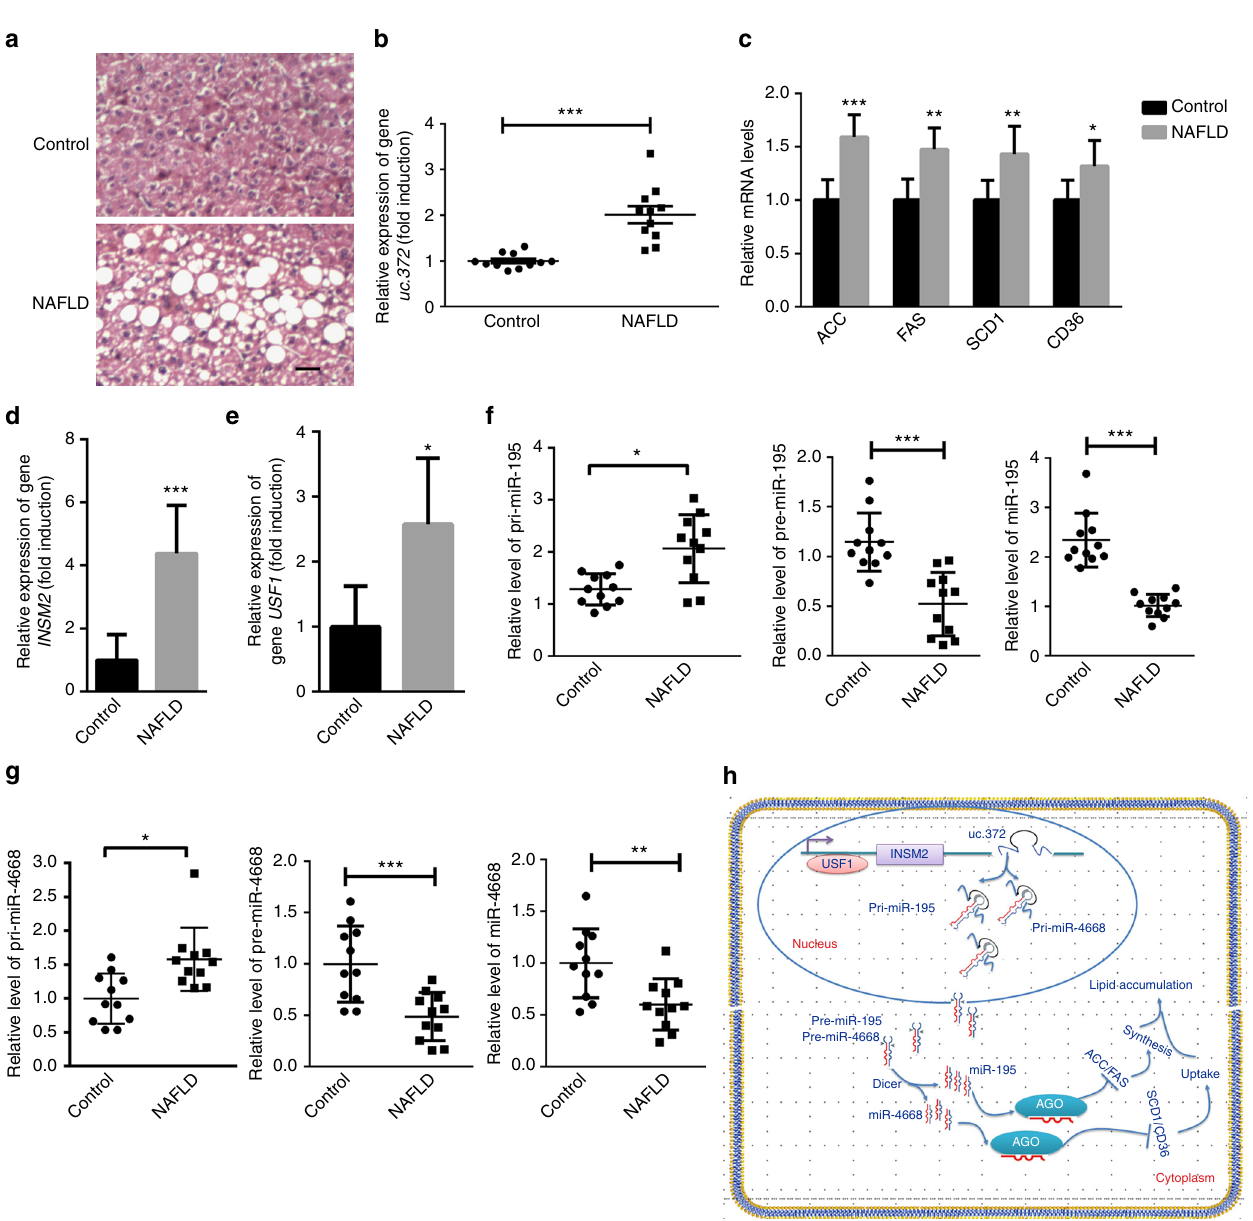
Fig. 8 Effect of uc.372 on abnormal lipid accumulation is subjected to regulation of miR-195/ miR-4668 in the liver of NAFLD patients. a Oil Red O staining of liver frozen sections from NAFLD patients or healthy control (representative image from three similar experiments). Scale bar, 100 μ m. b The level of uc.372 in the liver samples of NAFLD patients or healthy control ( n = 11). c The mRNA levels of ACC , FAS , SCD1 , and CD36 in the liver samples of NAFLD patients or healthy control ( n = 3). d The mRNA level of INSM2 in the liver samples of NAFLD patients or healthy control ( n = 11). e The mRNA level of USF1 in the liver samples of NAFLD patients or healthy control ( n = 11). f The levels of pri-miR-195, pre-miR-195, and mature miR-195 in the liver samples of NAFLD patients or healthy control ( n = 11). g The levels of pri-miR-4668, pre-miR-4668, and mature miR-4668 in the liver samples of NAFLD patients or healthy control ( n = 11). h Schematic depicting our proposed model that us.372 drives hepatic lipid accumulation. Data are mean ± SEM; Student ’ s t -test: * P < 0.05; ** P < 0.01; *** P < 0.001 vs. control